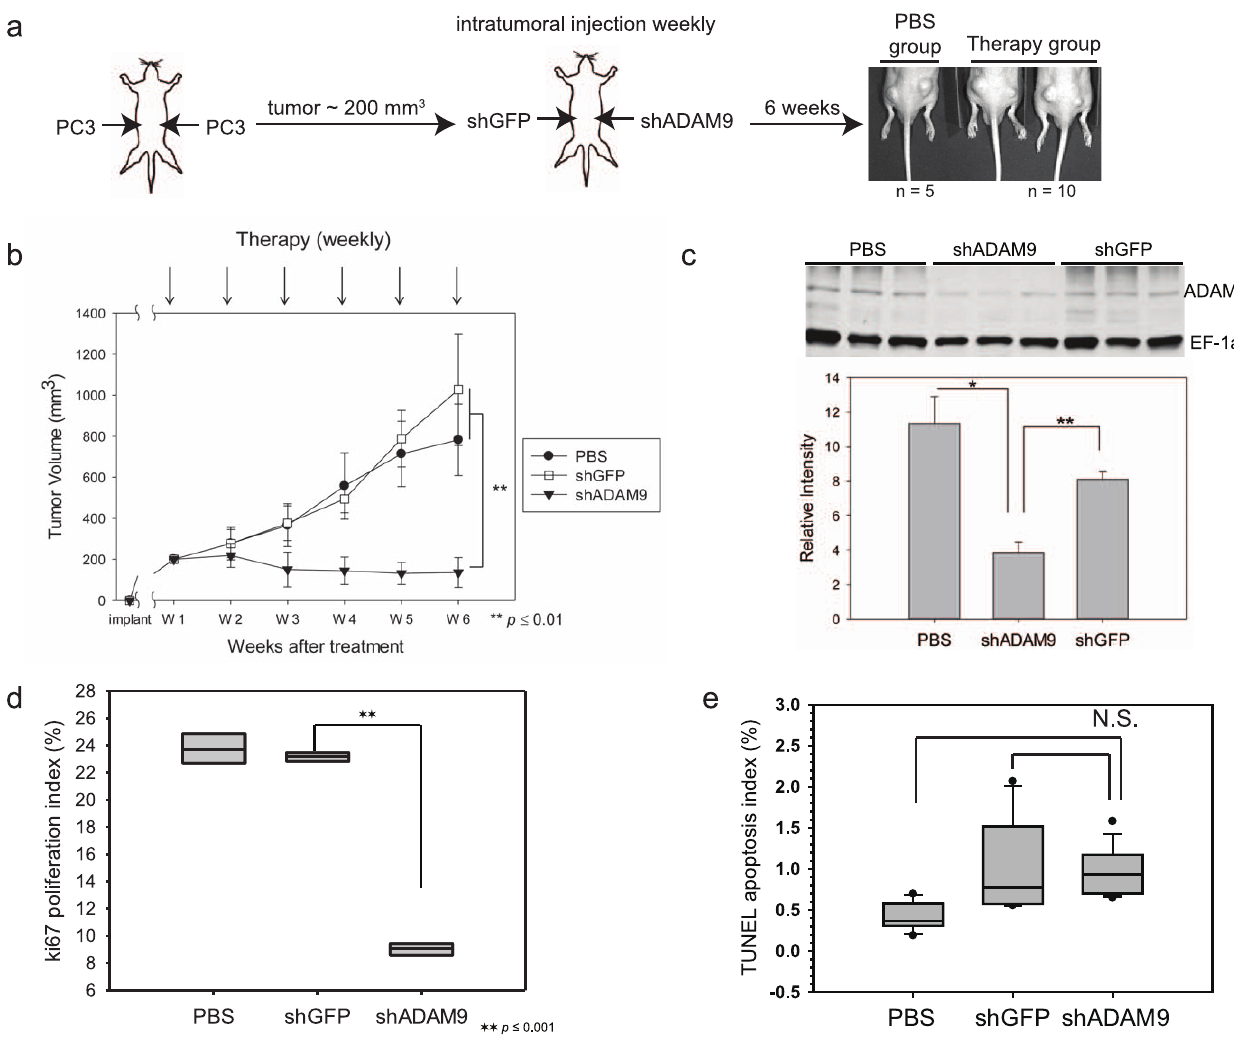
Figure 3. ADAM9 reduction therapy decreased tumor volume by inhibiting cancer cell proliferation. (a) Schematic of ADAM9 knockdown therapy experiment. Mice were injected subcutaneously with PC3 cells in both flanks, and tumor size was measured twice a week until the size reached approximately 200 mm 3 . Mice then received injections of either PBS into both tumor sites (n=5) or shGFP lentivirus into the left side tumor and shADAM9 into the right side (n=10). Viruses were injected and tumors measured weekly for 6 consecutive weeks. (b) After shADAM9 therapy, tumor volumes did not increase compared to shGFP therapy or PBS controls (** p # 0.01, Student’s t test). (c) Immunoblotting assay of ADAM9 expression confirms decreased ADAM9 expression after shADAM9 therapy. EF-1 a was used as a loading control (* p # 0.05; ** p # 0.01, Student’s t test). (d) Statistical analysis of ki67 staining. shADAM9 therapy significantly decreased cell proliferation activities in PC3 tumors. PBS and shGFP therapy showed no difference in the proliferation index (** p # 0.001, One Way ANOVA). (e) Statistical analysis of TUNEL staining showed